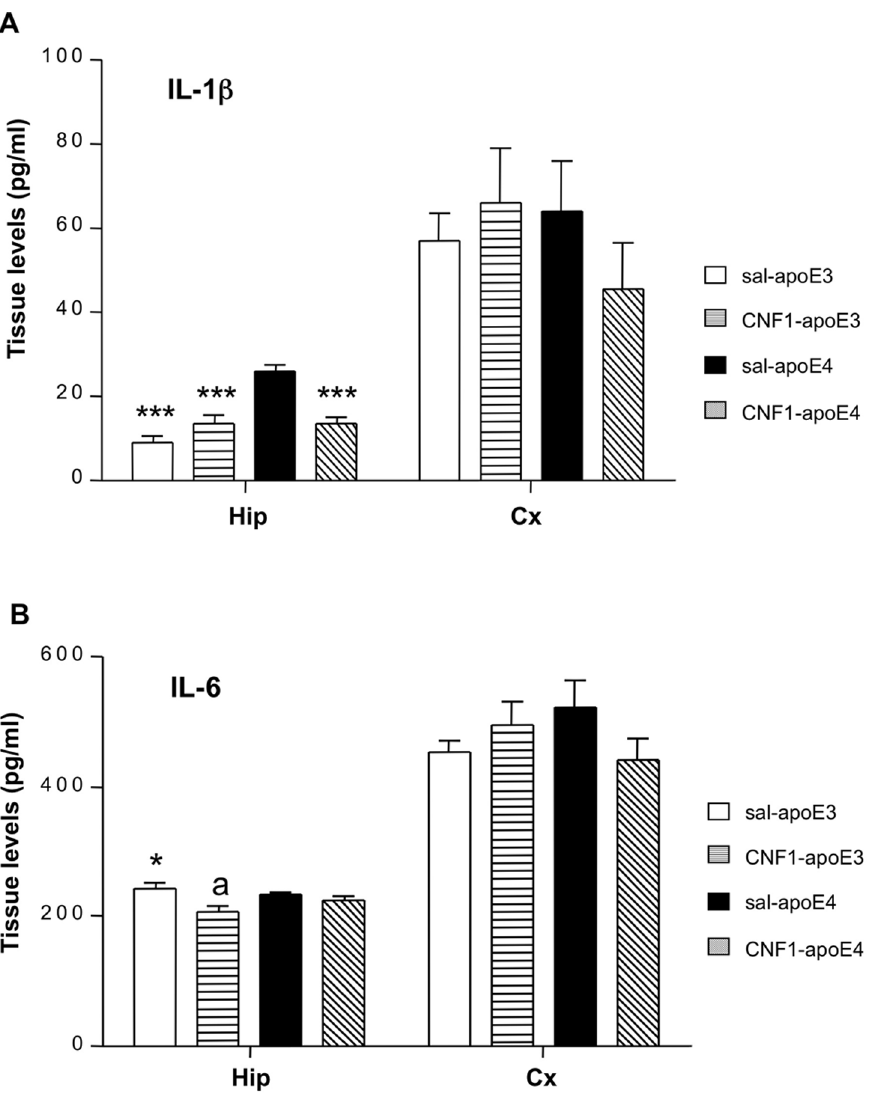
Figure 5. CNF1 treatment diminished IL-1 b in the hippocampus of apoE4 mice. Hippocampal (Hip) and cortical (Cx) samples from apoE3 and apoE4 mice, treated with saline or CNF1, were analyzed by ELISA. A. Graph showing IL-1 b levels: CNF1 was able to significantly decrease IL-1 b levels in the hippocampus of apoE4 mice to values comparable to those of ApoE3 mice, while having no effect in apoE3 healthy mice. B. Graph showing IL-6 levels: CNF1 was not able to mofify IL-6 amount either in hippocampus or in frontal cortex of apoE3 and apoE4 mice. Data are shown as mean 6 SEM (pg/ml). Sal-apoE3 mice were used as reference. *p , 0.05 vs sal-apoE4; ***p , 0.001 vs sal-apoE4, a p , 0.05 sal-apoE3 vs CNF1-apoE3; n=7 per